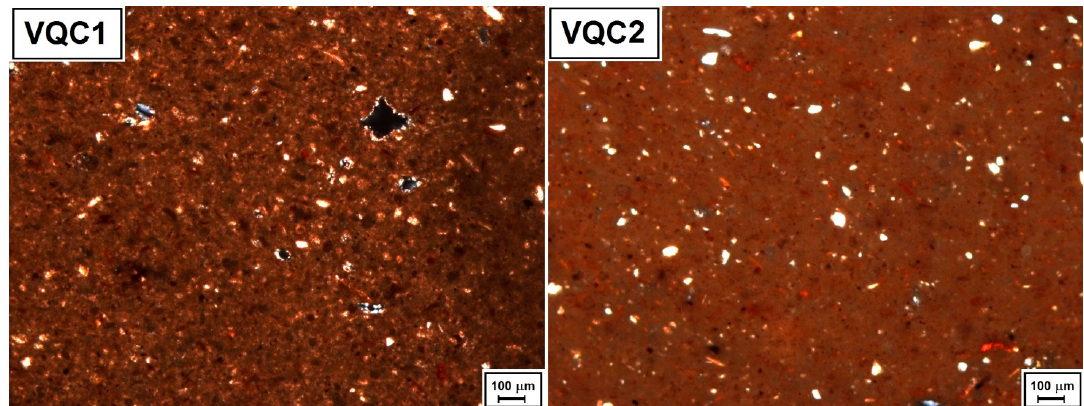
Figure 3. Representative photomicrographs at crossed polars of samples VQC1 and VQC2. Table 2. Main minero-petrographic features of investigated samples as obtained by polarising optical microscopy (POM) and XRD. Notes: Cal = calcite; Di = diopside; Fds = feldspars; Fe-ox = iron oxides; Gh = gehlenite; Gy = gypsum; Pl = plagioclase; Qtz = quartz; Ho = homogeneous; WS = well-sorted; S = sorted; P = present; / = absent; c/f/v = the ratio of coarse, fine, and void components of the fabric (%). Minero-Petrographic Features by POM